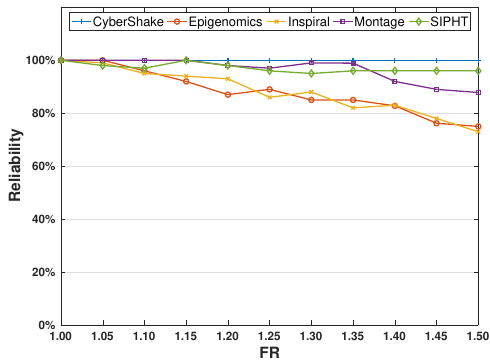
Figure 4. Reliabilities of workflows with the increasing failure rate